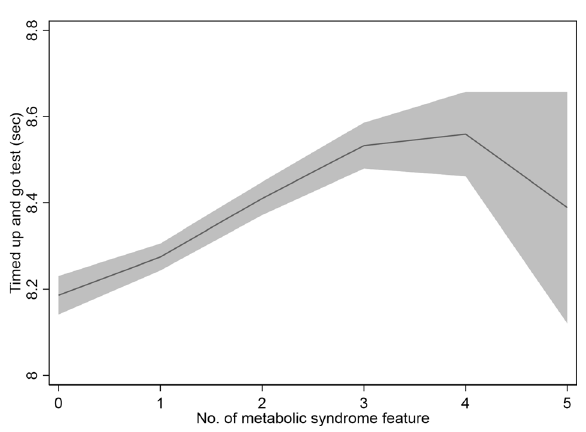
Figure 1. Association of Timed up and go test with the number of metabolic syndrome features. Gray area depicts 95% confidence